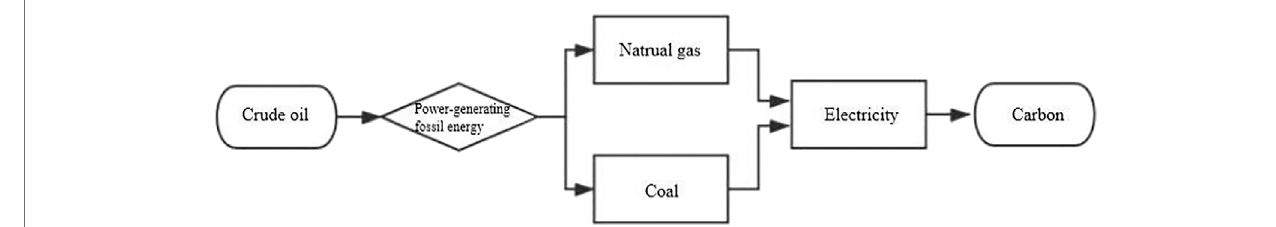
FIGURE 3 | Industrial chain relationship between crude oil and carbon emission